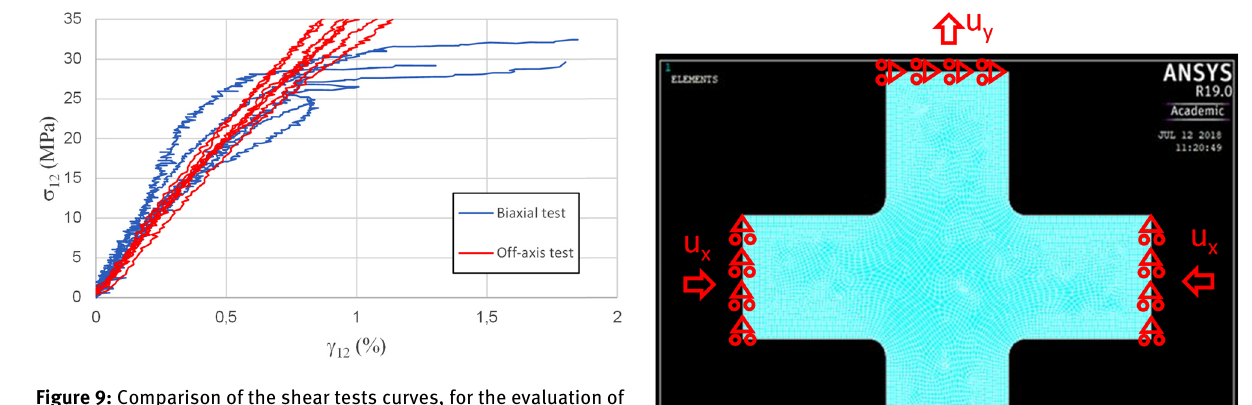
Figure 9: Comparison of the shear tests curves, for the evaluation of the shear modulus ( G 12 ) using the biaxial test with cruciform spe - cimens and the o ff - axis 10° test.